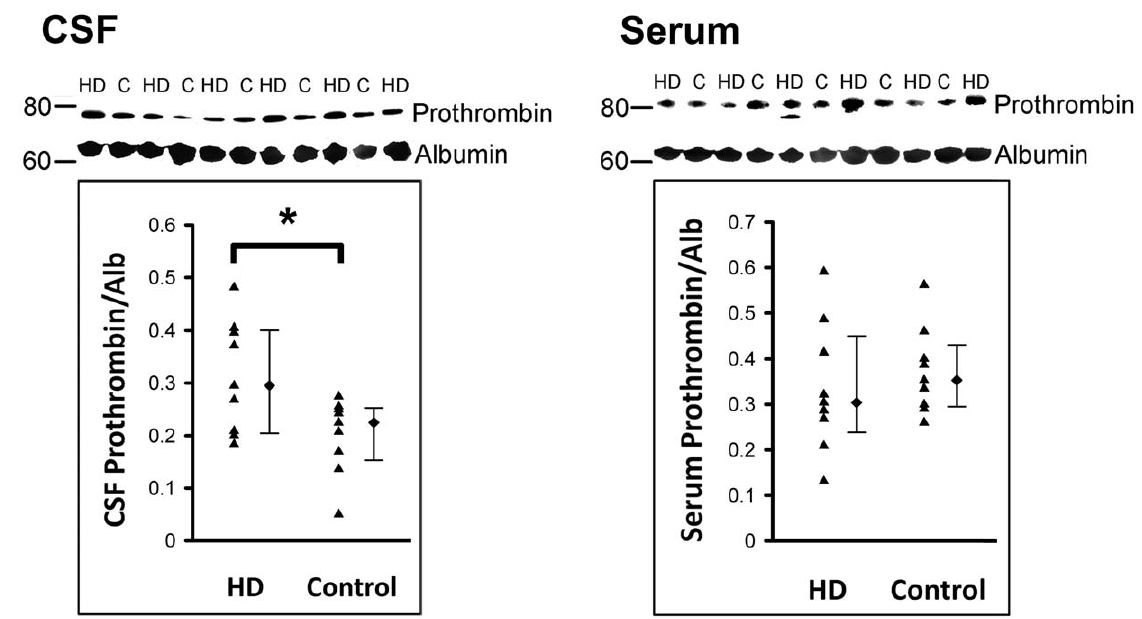
Figure 2. Representative Western blots of prothrombin (72 kD) and albumin (64 kD) in CSF and serum of HD patients and their corresponding controls (C). The resulting data are illustrated in scatter plots with median and interquartile range. The prothrombin/Alb ratio in CSF of HD patients (n=9) is higher than that in controls (n=9). * p , 0.05, Mann-Whitney U test. doi:10.1371/journal.pone.0015809.g002 PLoS ONE |